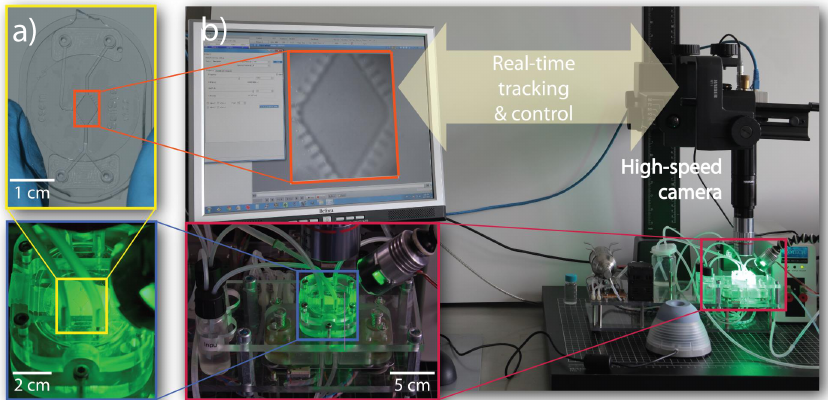
Figure 6. The automated, closed control loop of the SelfSys platform [10]. ( a ) The 1 cm long, centro-symmetric chamber molded in a 400 µ m-thick layer of polydimethylsiloxane (PDMS) and sealed between two glass slides; ( b ) The high-speed GigE camera (Fastec HighSpec 1) with a microscope lens assembly mounted above the chamber for tracking